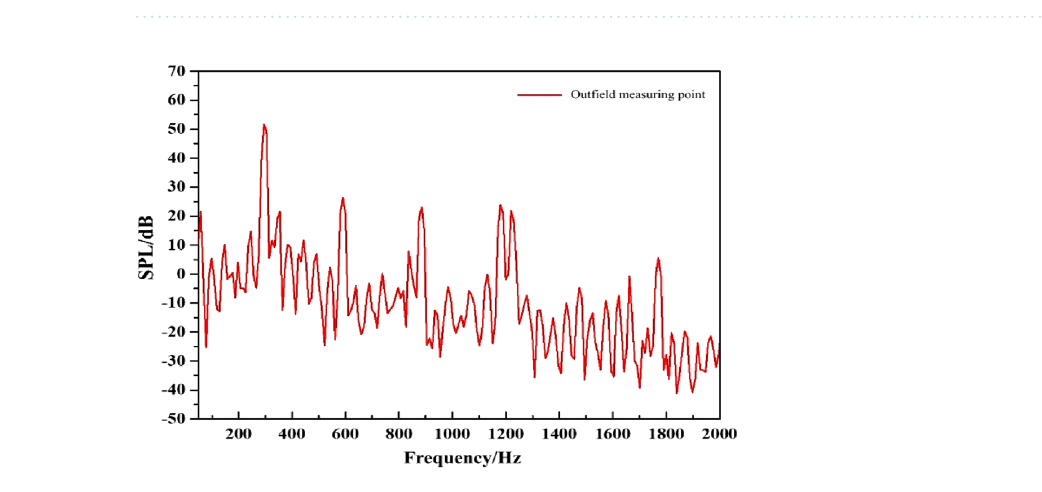
Figure 20. The spectrum of outfield noise by the rotating